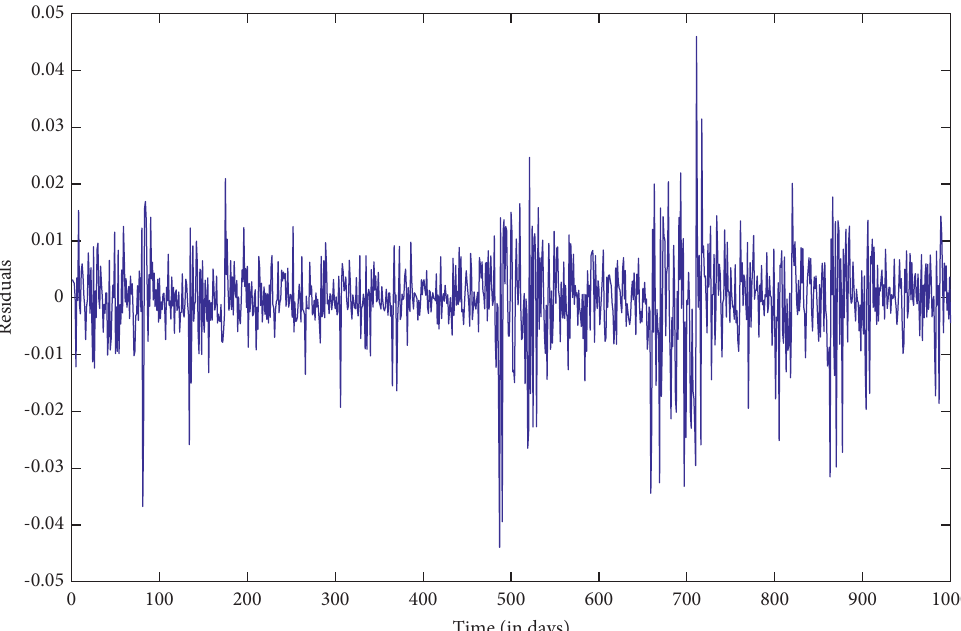
Figure 4: The S&P 500 residual